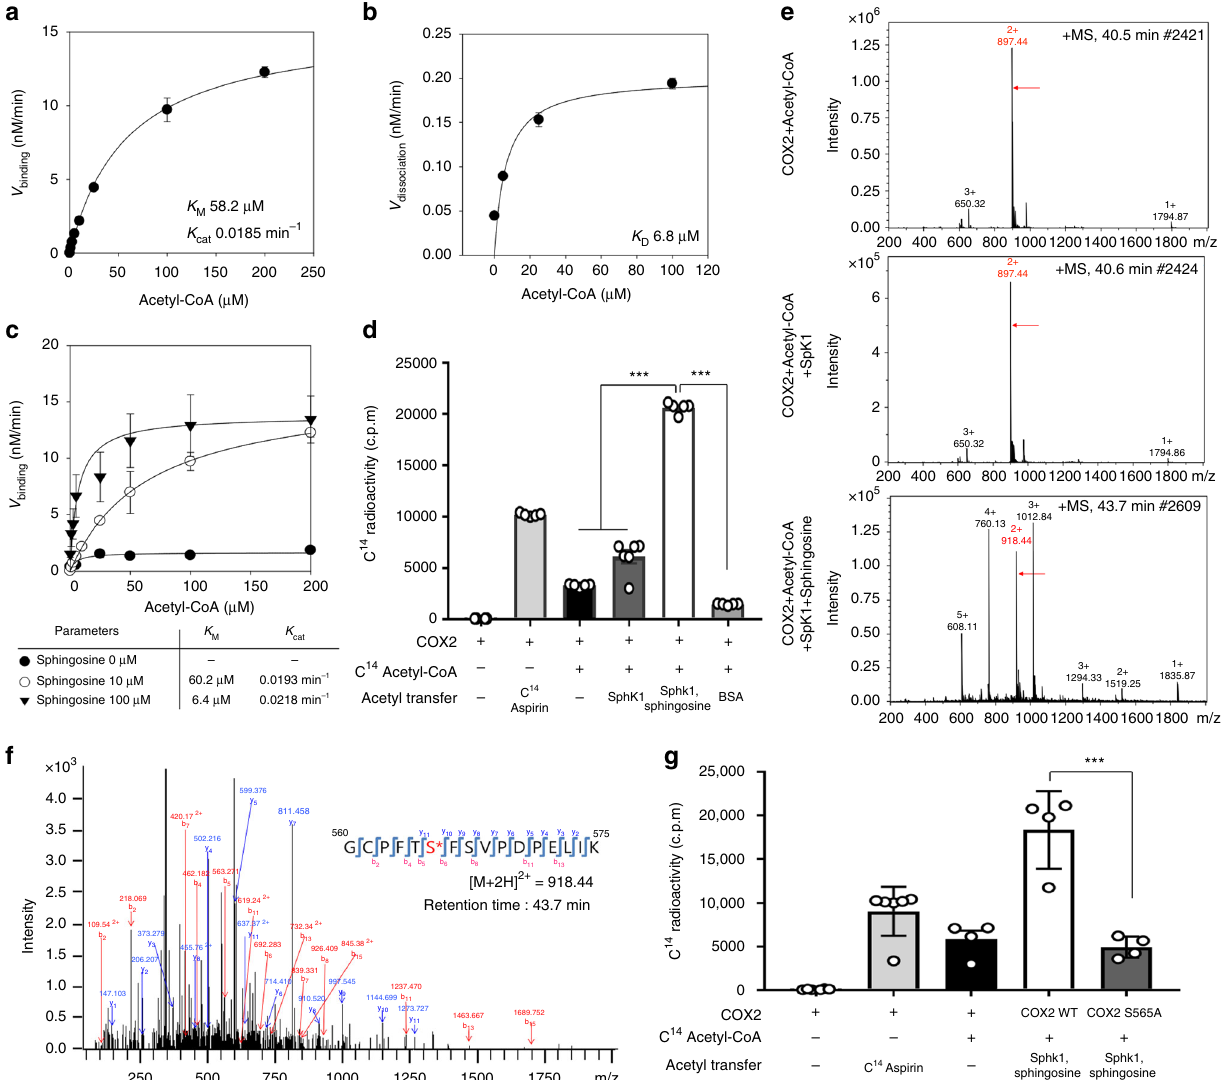
Fig. 4 SphK1 plays a role of acetyltransferase, acetylating S565 of COX2 in neurons. a Acetyl-CoA binding activity of SphK1 was analyzed by fi lter binding assay with 10 μ M sphingosine. The binding velocity ( V binding ) of [ 3 H] acetyl-CoA to SphK1 was plotted to the acetyl-CoA concentration and the nonlinear regression analysis of the saturated plot yielded the kinetic parameters such as K cat (catalytic constant) and K M (Michaelis − Menten constant) for acetyl- CoA and SphK1 binding activity ( n = 3 per group). b Dissociation of acetyl group from SphK1 was analyzed by equilibrium dialysis in the presence of 0, 5, 25, and 100 μ M free acetyl-CoA. The dissociation rate ( V dissociation ) of [ 3 H] acetyl group from [ 3 H] acetyl-CoA and SphK1 complex was plotted against inhibitor-free acetyl-CoA concentration and dissociation constant ( K D ) was calculated from the nonlinear regression analysis ( n = 3 per group). c Acetyl- CoA binding activity of SphK1 was analyzed by fi lter binding assay in the presence of 0, 10, and 100 μ M sphingosine ( n = 3 per group). d Acetylation assay of puri fi ed COX2 protein treated with SphK1 and [ 14 C] acetyl-CoA in the presence of 100 μ M sphingosine or not. BSA-treated COX2 protein was negative control ( n = 4 – 6 per group). e LC-MS spectra of peptide 560-GCPFTSFSVPDPELIK-575 ( m/z = 918.44) of COX2 acetylated by SphK1, acetyl-CoA and sphingosine. f LC-MS/MS spectra of ac-S565 in 560-GCPFTSFSVPDPELIK-575 of COX2. g Acetylation assay of COX2 WT and COX2 S565A recombinants treated with SphK1 and [ 14 C] acetyl-CoA in the presence of 100 μ M sphingosine ( n = 4 – 6 per group). d One-way analysis of variance, Tukey ’ s post hoc test. g Student ’ s t test. *** P < 0.001. All error bars indicate